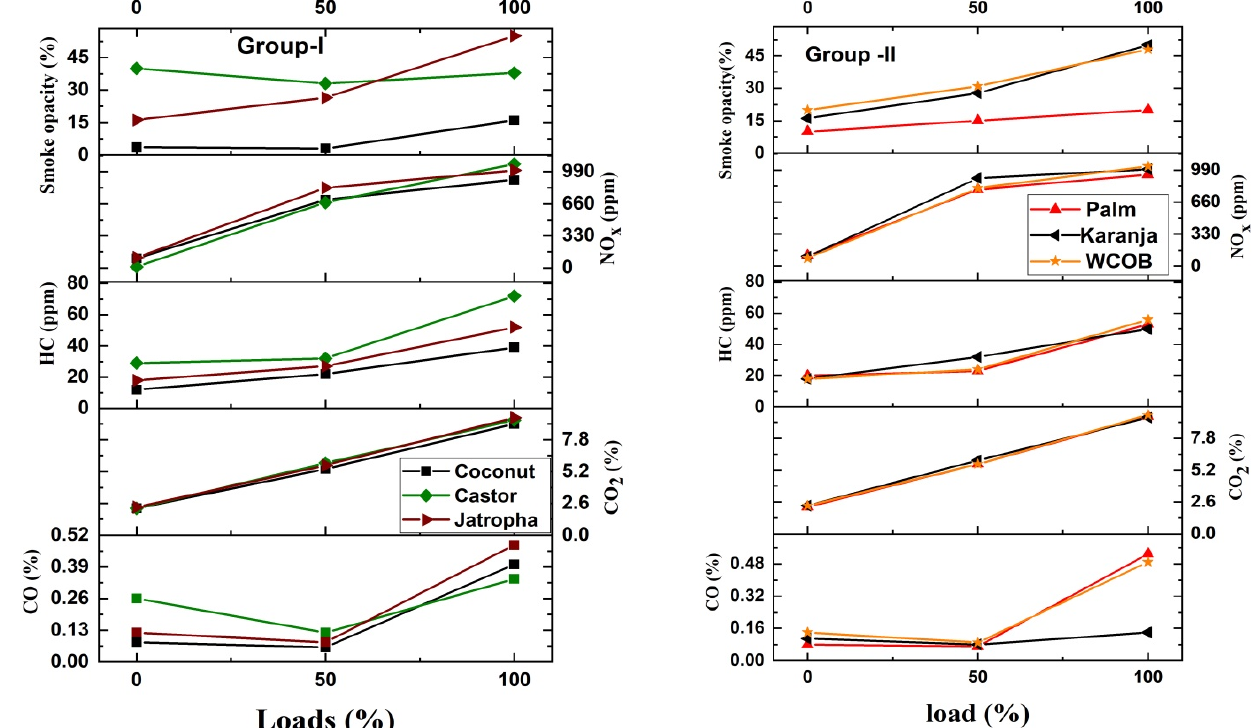
Figure 10. Exhaust gas emissions as a function of engine load and biodiesel type.